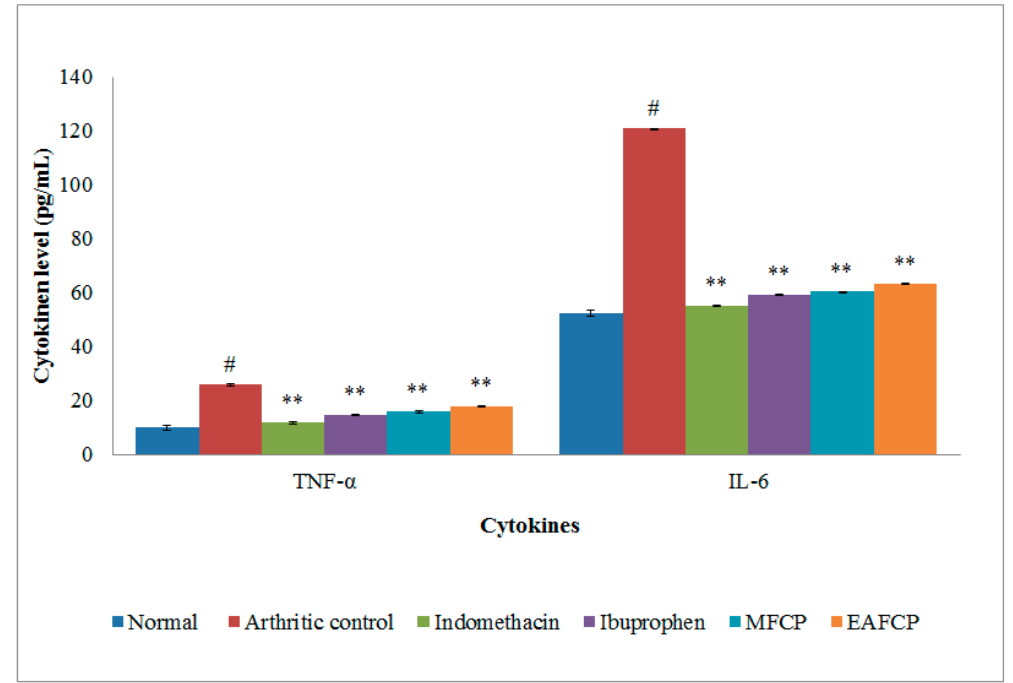
Figure 4. Effects of Swallow wort fractions on cytokine production in serum. Values are mean ± SEM for 6 animals; statistical analysis by one-way ANOVA followed by Dunnett test using Graphpad Instat software; ** p < 0.01 when compared to arthritic control and # p < 0.01 when compared to normal control.